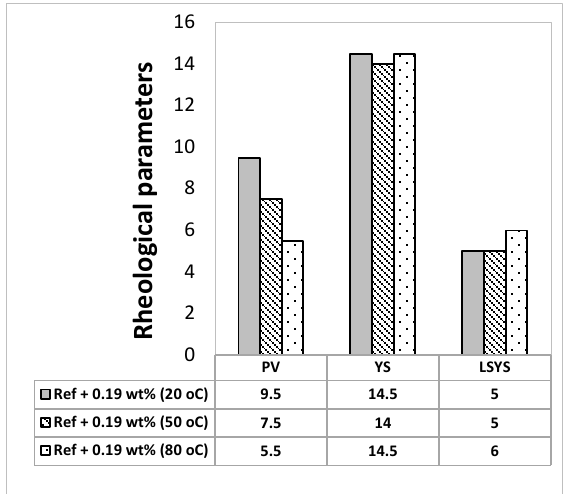
Figure 4. MoS 2 mixed drilling fluid — 0.19 wt.%.